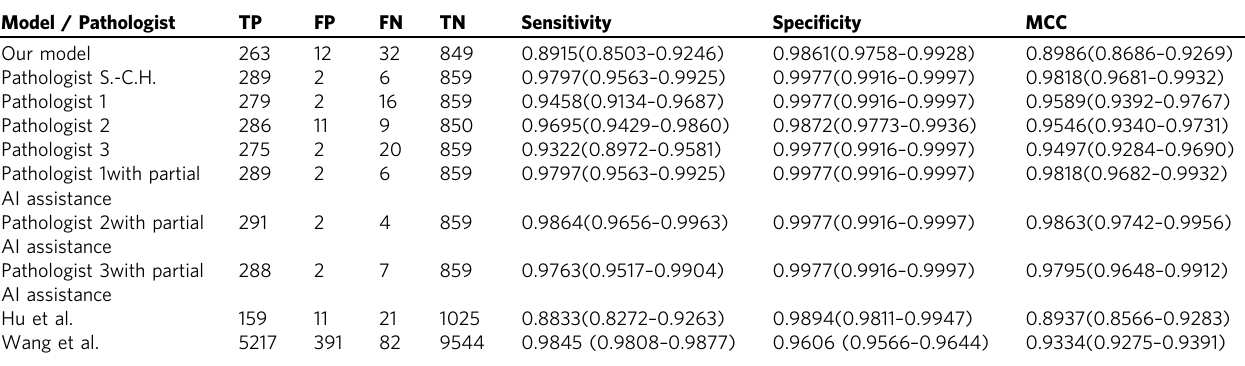
Table 1 Overview of the performance of our model, the pathologists, and previous